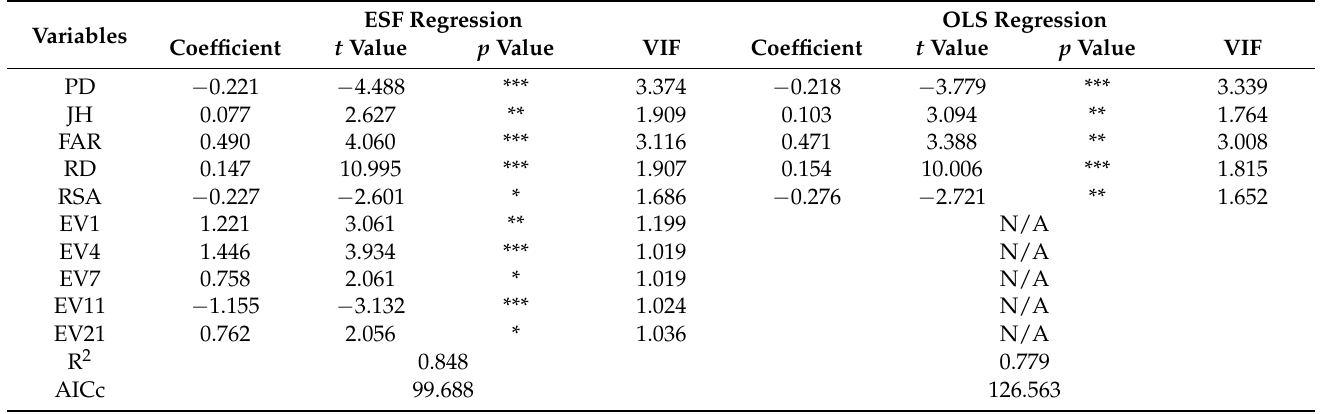
Table 11. Comparison of OLS regression and ESF regression (ln(Night_V) as the dependent variable). Variables